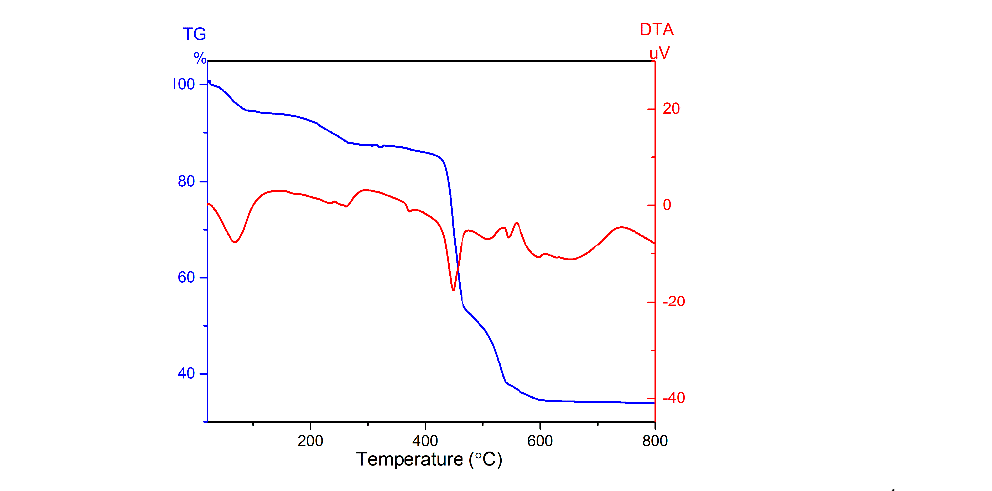
Figure 2. TG (blue) and DTA (red) curves of the [N(CH 3 ) 4 ] 2 ZrF 6 :1%Mn 4+ sample recorded under N 2 atmosphere.